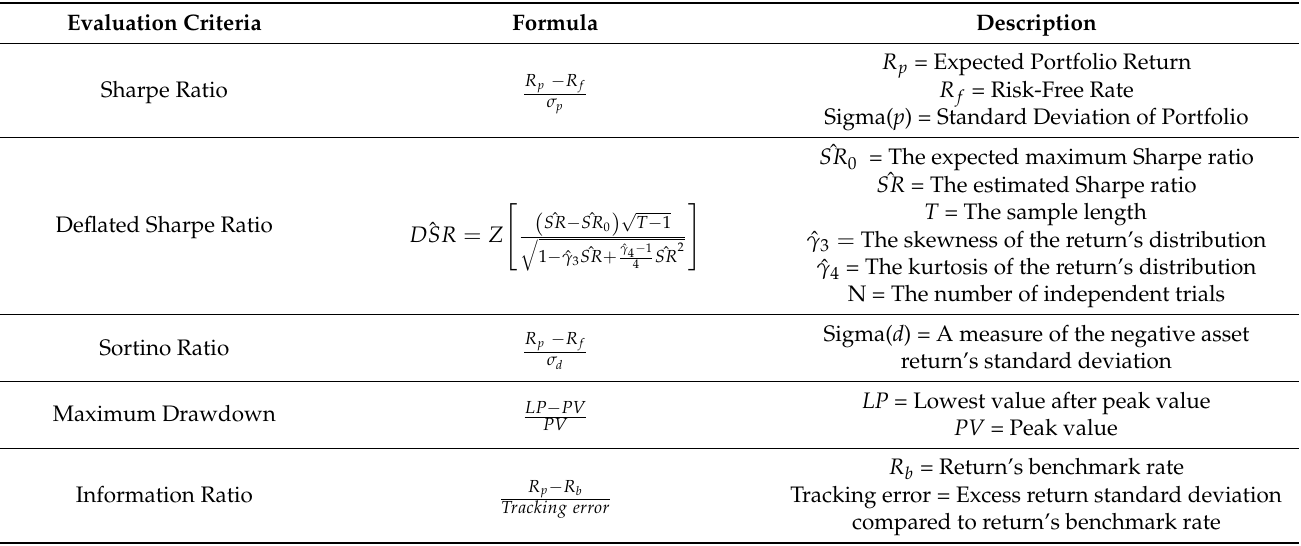
Table 7. Risk-adjusted return criteria formula.